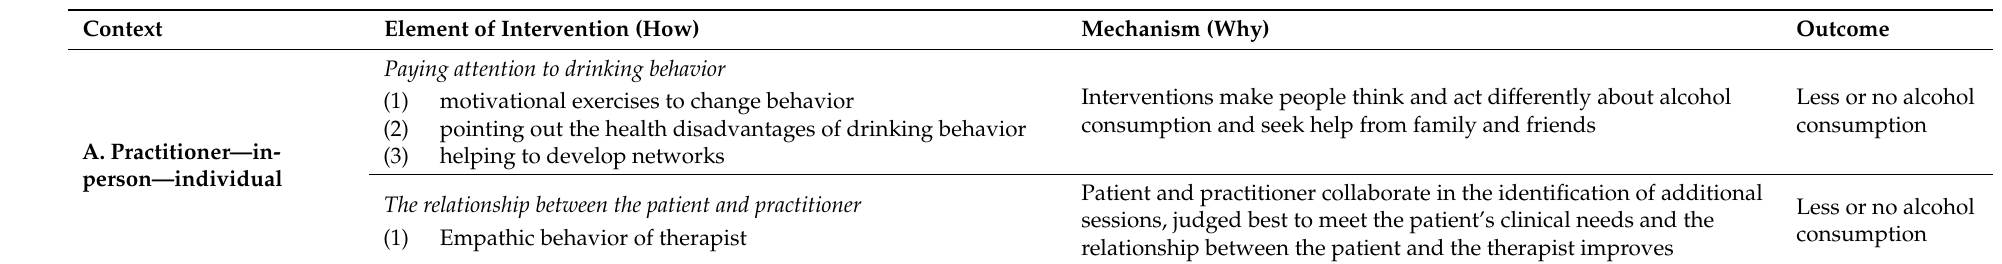
Table 5. Summary of the